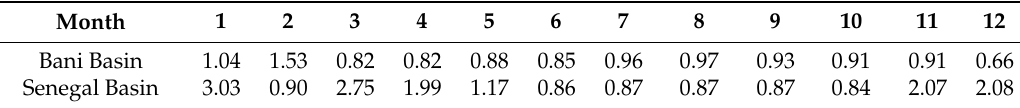
Table 5. Bias coefficients correction of PERSIANN-CDR